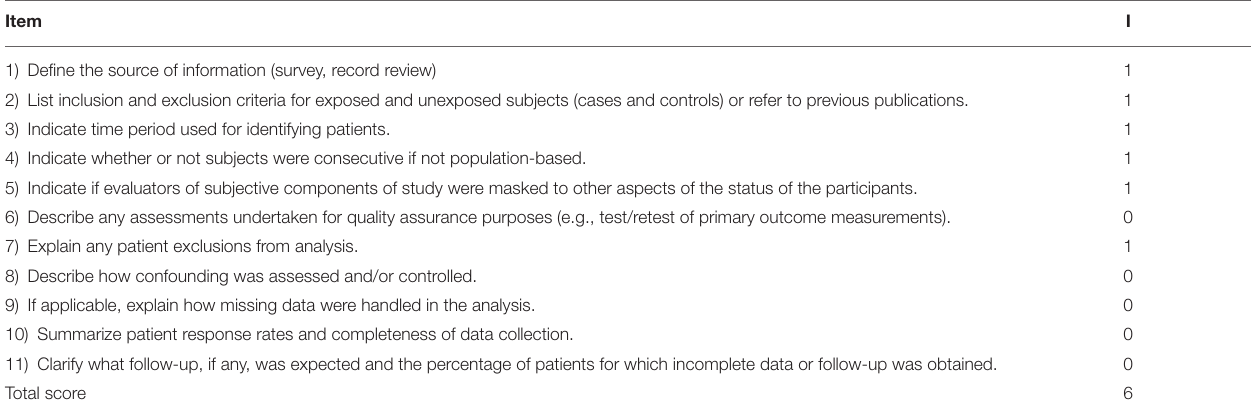
TABLE 4 | Agency for healthcare research and quality (AHRQ) checklist (cross-sectional) for 2 studies a included in this meta-analysis.